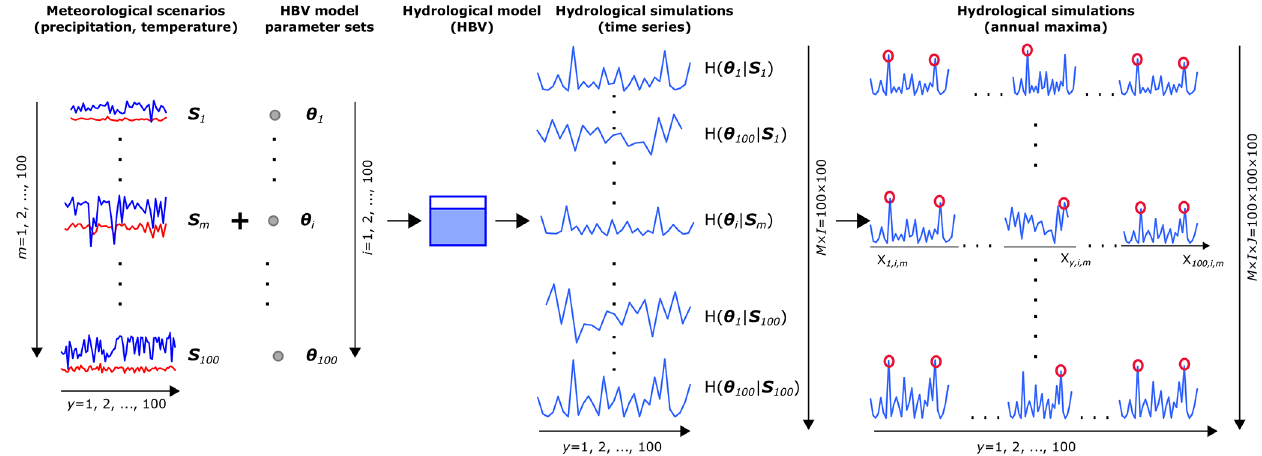
Figure 4. Set-up of the experimental study. Table 2. The three representative parameter sets θ inf , θ med and θ sup most frequently selected with three methods. The i stands for the set index and ct. for the number of counts. The expression (cid:80) ct. stands for the sum of counts for the first three most frequently selected sets. Bold font indicates parameter set indices which are selected as representative with at least two methods among the three sets most frequently chosen. Method Ranking Quantiling Clustering Repr. set Par.